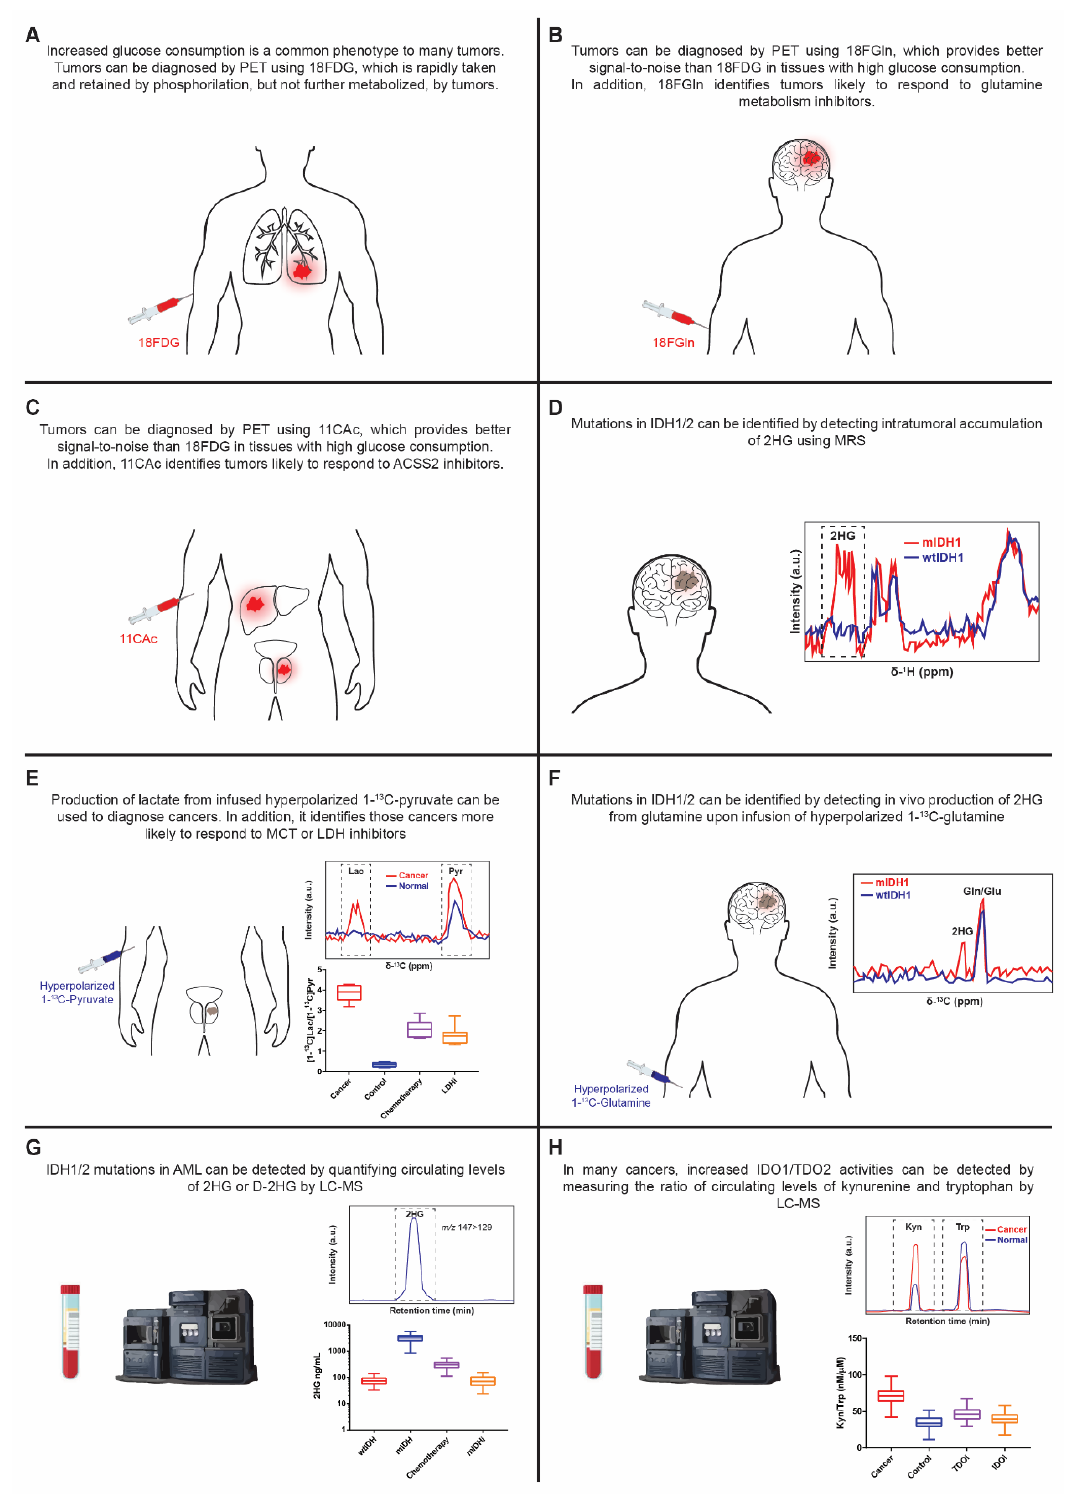
Figure 4. Metabolic activities/metabolites and the associated noninvasive techniques for their assessment with diagnostic, therapy selection and efficacy prospects. ( A ). PET-based detection of infused 18FDG. ( B ). PET-based detection of infused 18FGln. ( C ). PET-based detection of infused 11CAc. ( D ). MRS-based detection of infused 2HG. ( E ). MRI-based detection of 13C-Lactate produced from infused hyperpolarized 1-13C-pyruvate. ( F ). MRI-based detection of 13C-2HG produced from infused hyperpolarized 1-13C-glutamine. ( G ). LC-MS-based detection of circulating (D-)2HG. ( H ). LC-MS-based detection of circulating tryptophan and kynurenine. 18FDG: 18 F-2-deoxyglucose; 18FGln: 4- 18 F-(2S,4R)-fluoroglutamine; 11CAc: 1- 11 C-acetate; ACSS2: acetyl-CoA synthetase 2; IDO1: indoleamine 2,3 dioxygenase 1; TDO2: tryptophan-2,3-dioxygenase 2.